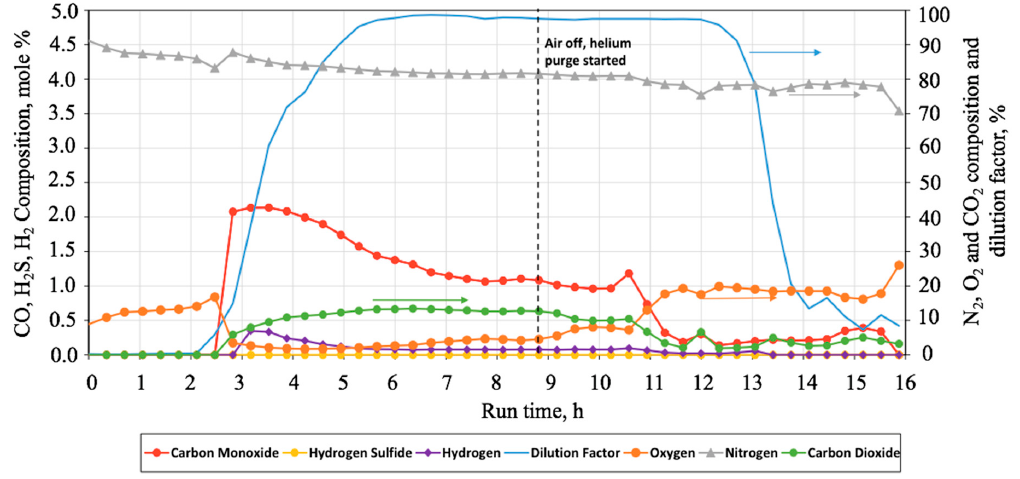
Figure 5. Produced Combustion Gas Compositions for Forward Combustion Test (Color should be used).